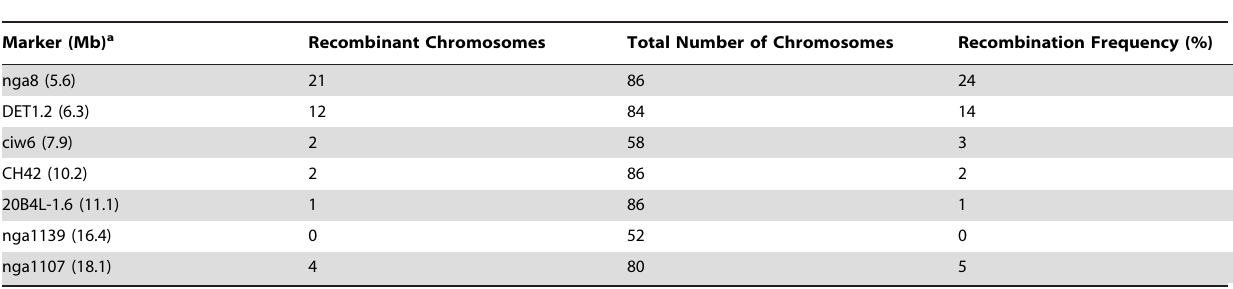
Table 3. Mapping of the Col-0 modifier gene in stunted F2 plants from the cross RLD 6 srfr1-4 .